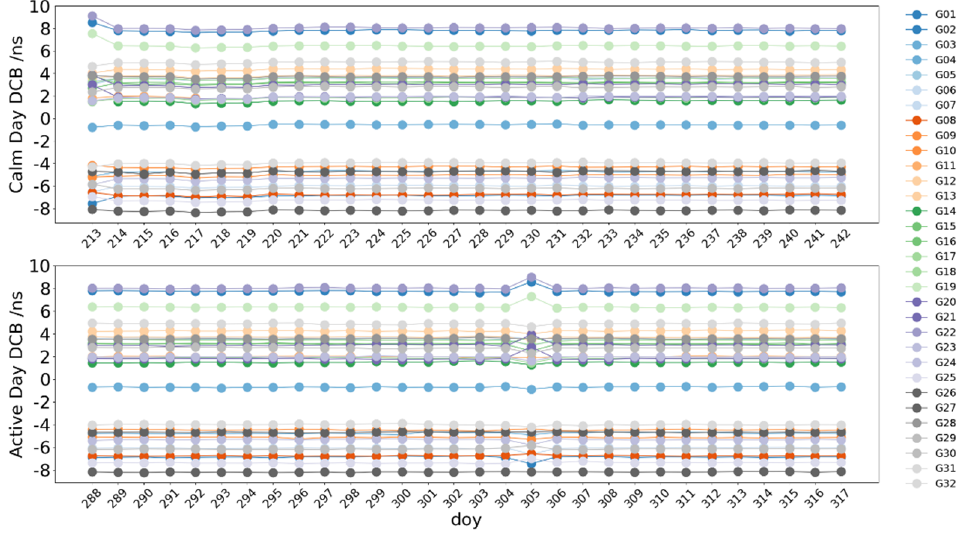
Figure 11. DCB time series of GPS satellites at different ionospheric conditions.